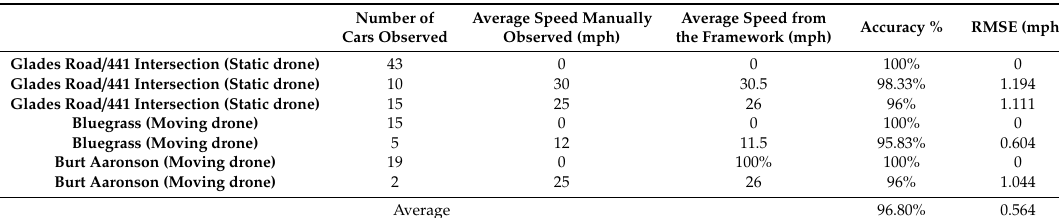
Table 2. Speed detection